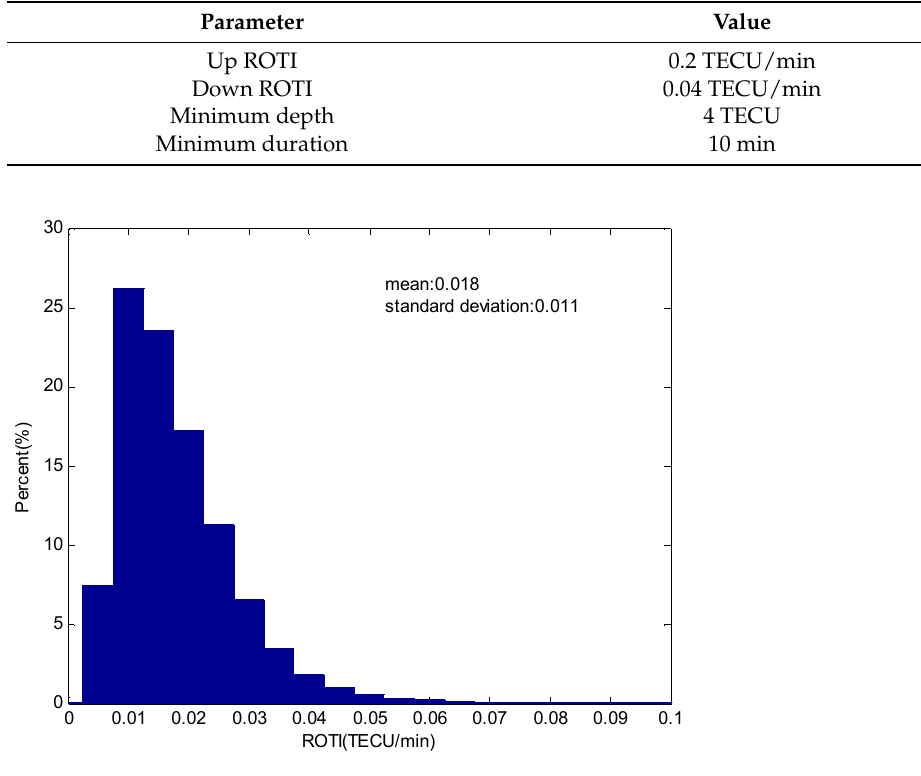
Figure 2. Percent distribution of the rate of TEC variation index (ROTI) calculated for the station HKKT during the year of 2014.